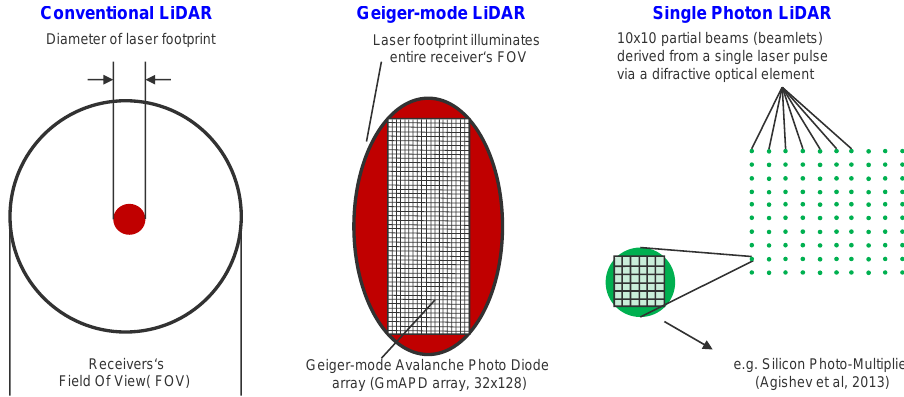
Figure 1. Principle sketch: Incoming laser radiation from the receiver’s